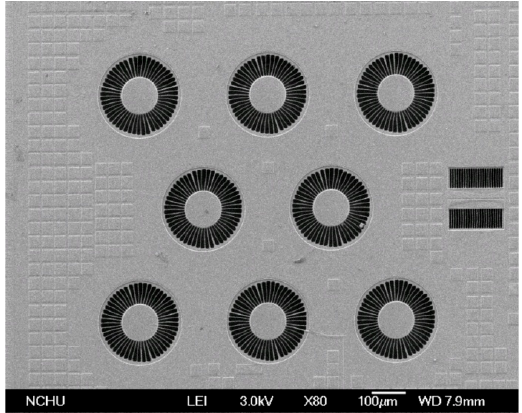
Figure 5. SEM image of the thermoelectric energy harvester.